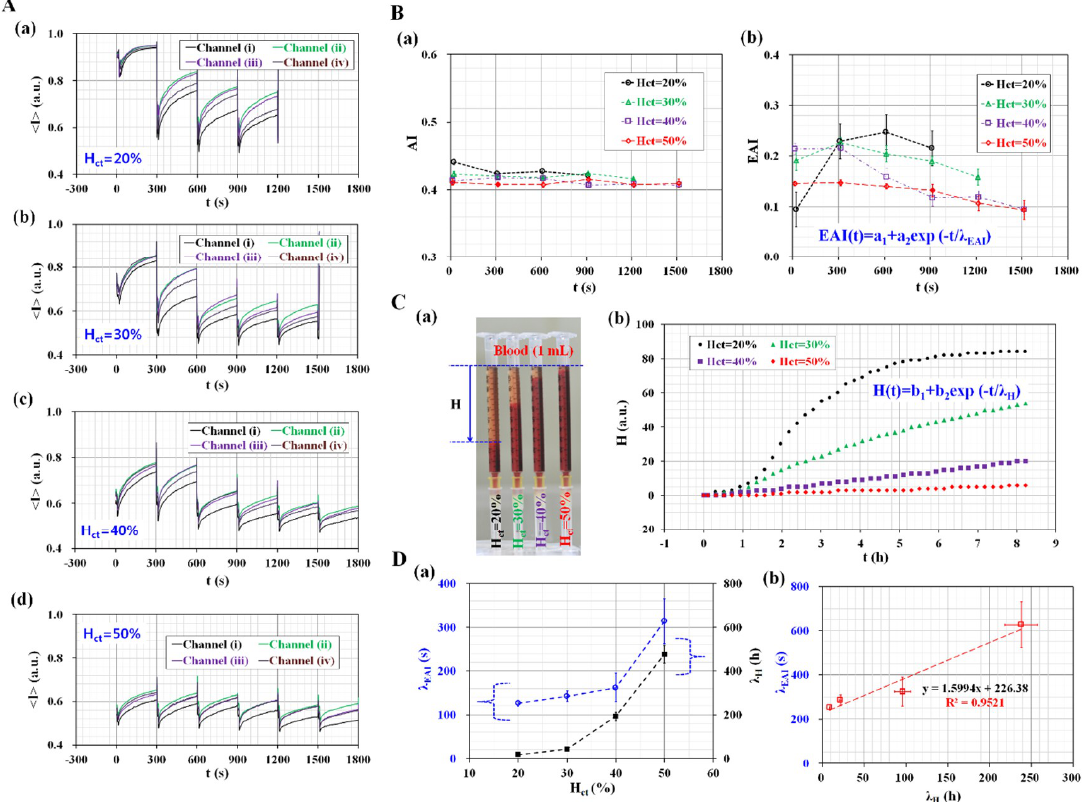
Figure 6. Quantitative evaluation of the effect of hematocrit on the performance of the proposed method. Specifically, RBC aggregation and ESR are quantified using two indices (AI and EAI). Hematocrit ( H ct ) ( H ct = 20%, 30%, 40%, and 50%) was adjusted by adding normal RBCs into autologous plasma. ( A ) Temporal variations of < I > with respect to each microfluidic channel and hematocrit ( H ct ) ([ A-a ] H ct = 20%, [ A-b ] H ct = 30%, [ A-c ] H ct = 40%, and [ A-d ] H ct = 50%). ( B ) Temporal variations of AI and EAI with respect to hematocrit. ( B-a ) Temporal variations of AI with respect to hematocrit. ( B-b ) Temporal variations of EAI with respect to hematocrit. ( C ) ESR measurement using a disposable syringe (~1 mL) as a conventional method. ( C-a ) Snapshot images for quantifying ESR method with respect to hematocrit. Here, H represents height in RBCs-depleted layer. ( C-b ) Temporal variations of H with respect to hematocrit. ( D ) Quantitative comparison between conventional method and proposed method. ( D-a ) Variations of λ EAI and λ H with respect to hematocrit ( H ct ). ( D-b ) Linear relationship between λ EAI and λ H .